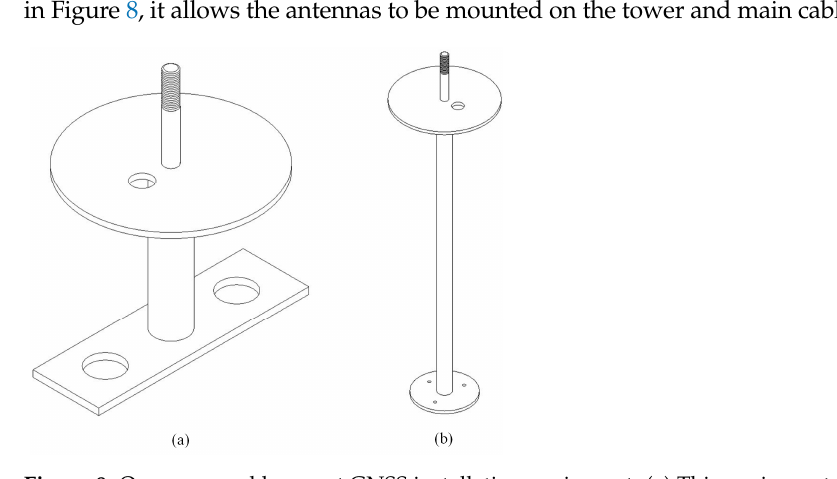
Figure 7. The prototypal low-cost GNSS sensor box and Micro PC mainboard. ( a ) The sensor box and Beitian BT-300 antenna. 1 = antenna, 2 = Micro PC mainboard, 3 = power supply; ( b ) The front of the Micro PC mainboard. 4 = WH-LTE-7S4 communication module; ( c ) The reverse side of the Micro PC mainboard. 5 = UB4BOM board with Nebulas-II UC4C0 system on chip (Soc).